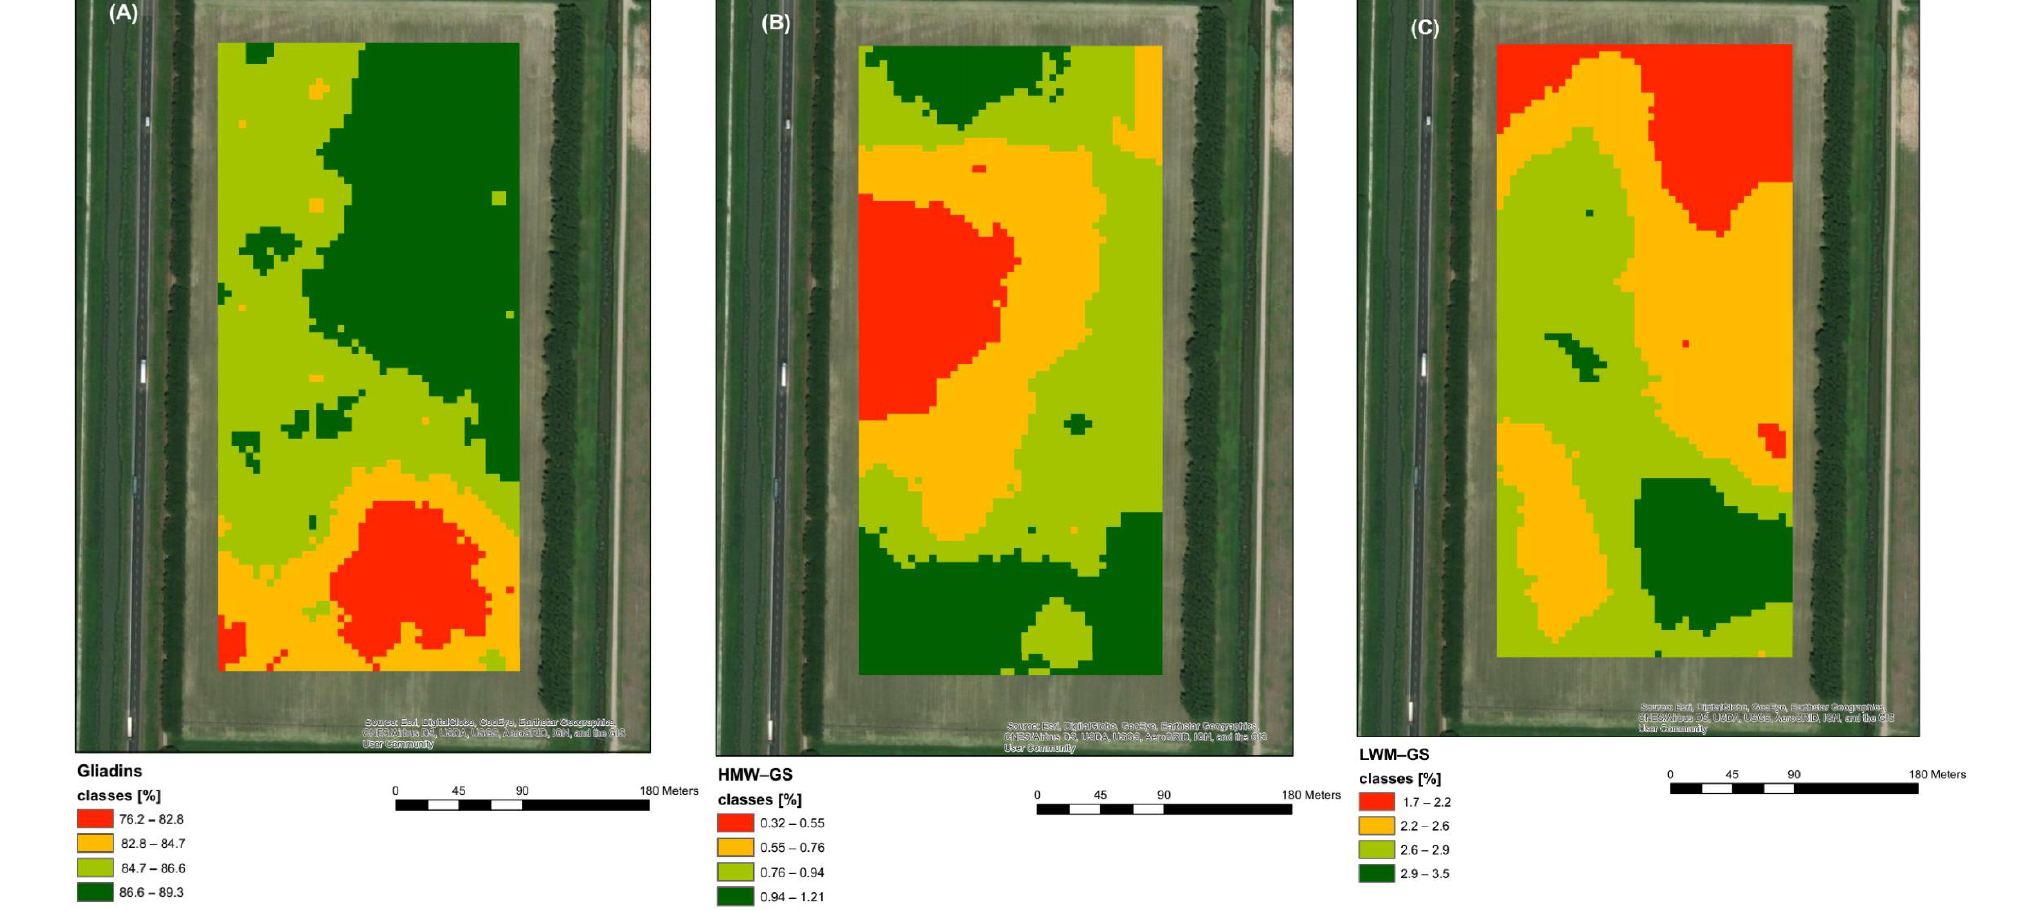
Figure 2. Maps of the contents of the different classes of gluten proteins in the field: ( A ) gliadins; ( B ) high-molecular-weight glutenins (HMW-GS); ( C ) low-molecular-weight glutenins (LMW-GS).